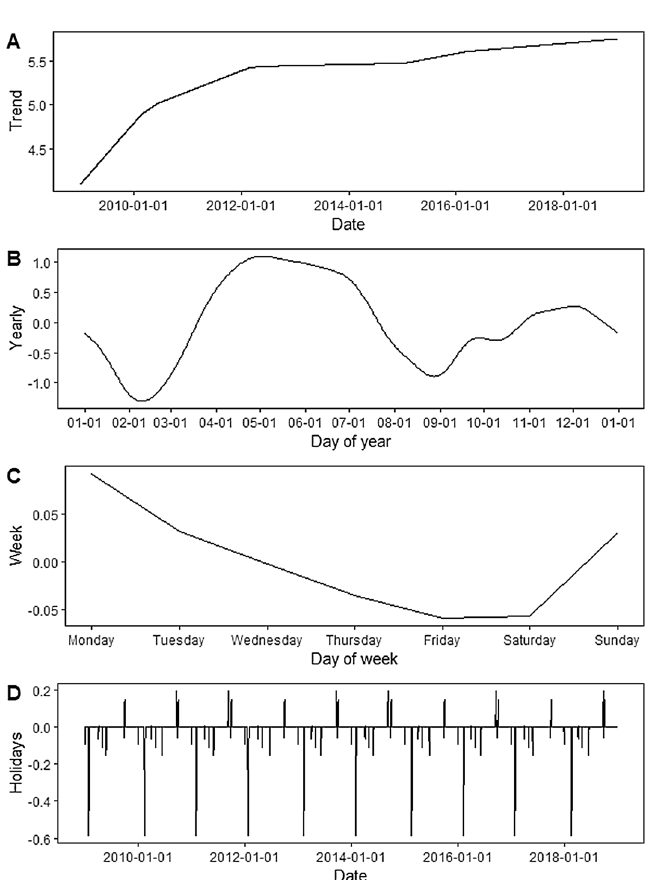
Figure 4. The decomposed components of the daily reported cases of HFMD time series in Hubei Province, China, including the effect of trend ( A ), the yearly ( B ), the weekly ( C ), and the holidays ( D